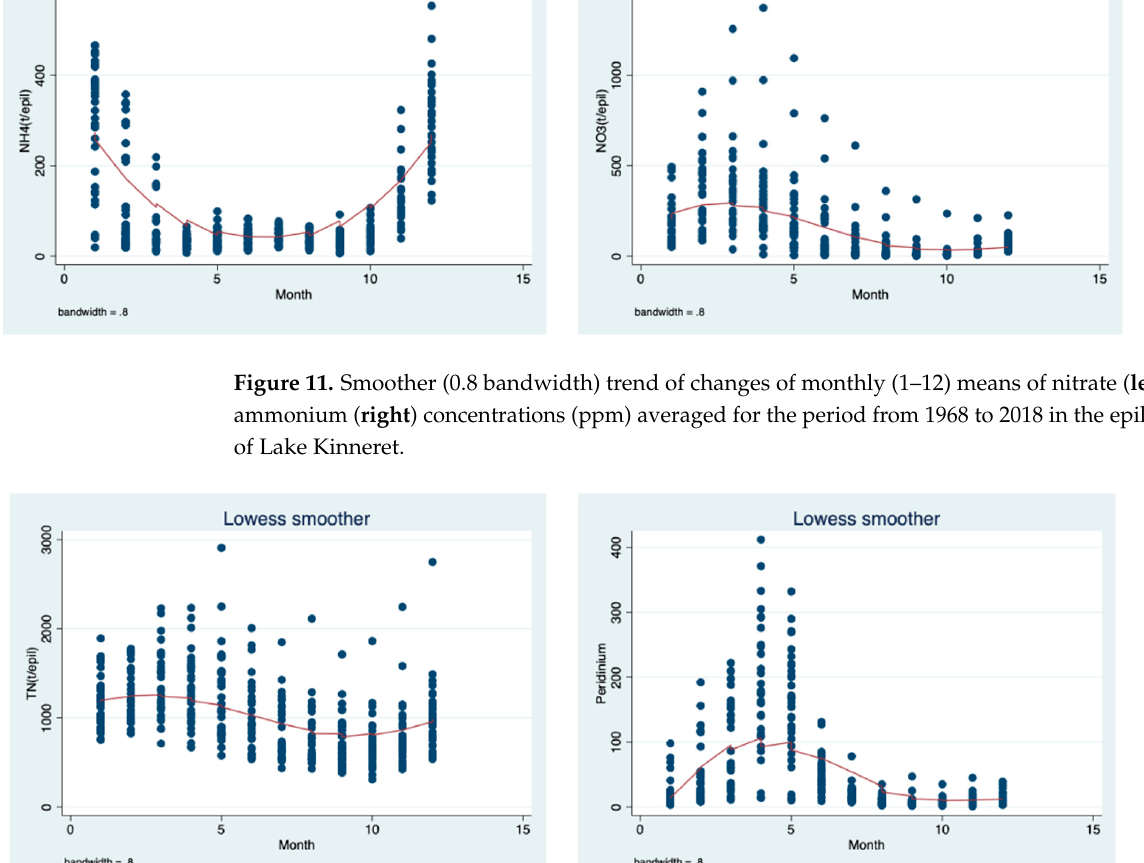
Figure 12. Smoother (0.8 bandwidth) trend of changes of monthly (1–12) means of Peridinium wet biomass (g/m 2 ) ( left ) and total nitrogen load (ton) in the epilimnion of Lake Kinneret, averaged for the period from 1970 to 2018.